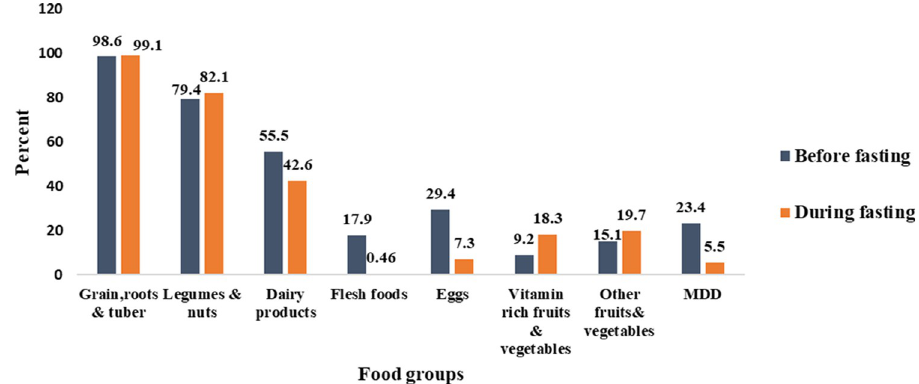
Fig 1. Food consumption pattern and MDD of children 6 to 23 months of age during the non-fasting and lent fasting periods in Debrebirhan, North Shewa Ethiopia, 2019.